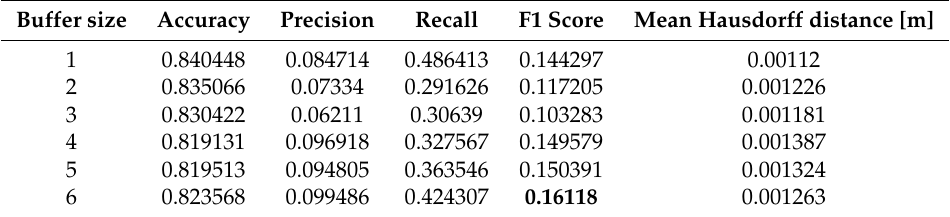
Table 3. PointCleanNet best results for multiple buffer sizes.